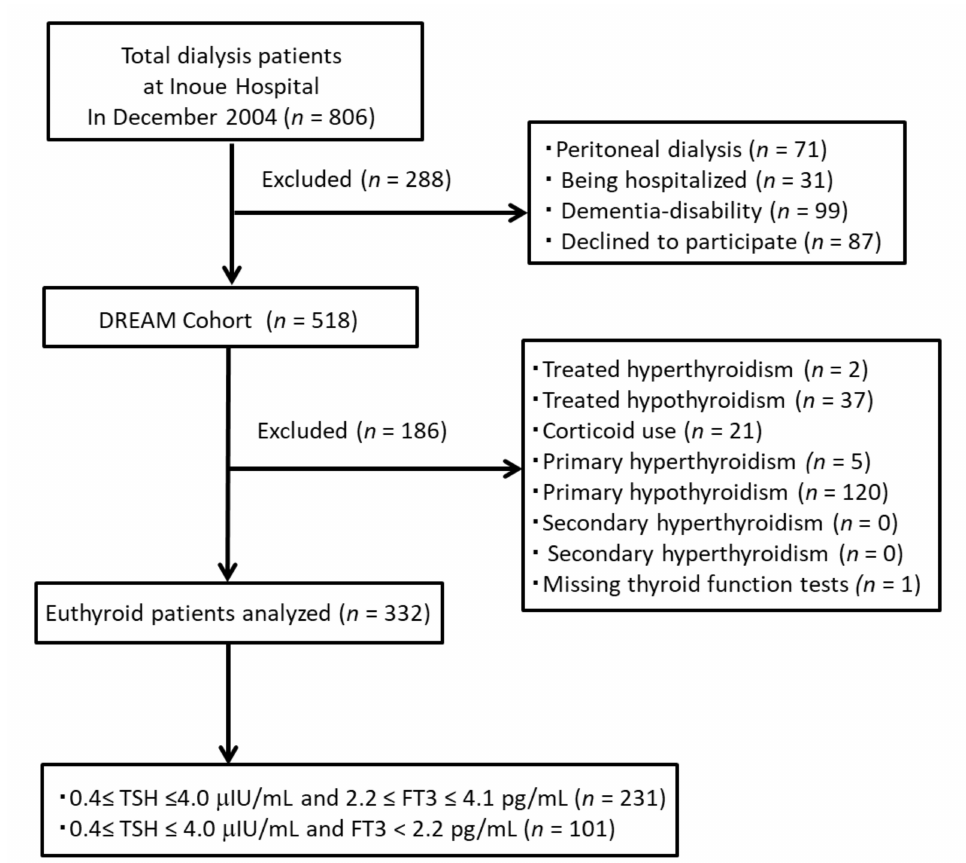
Figure 1. Selection of subjects for present